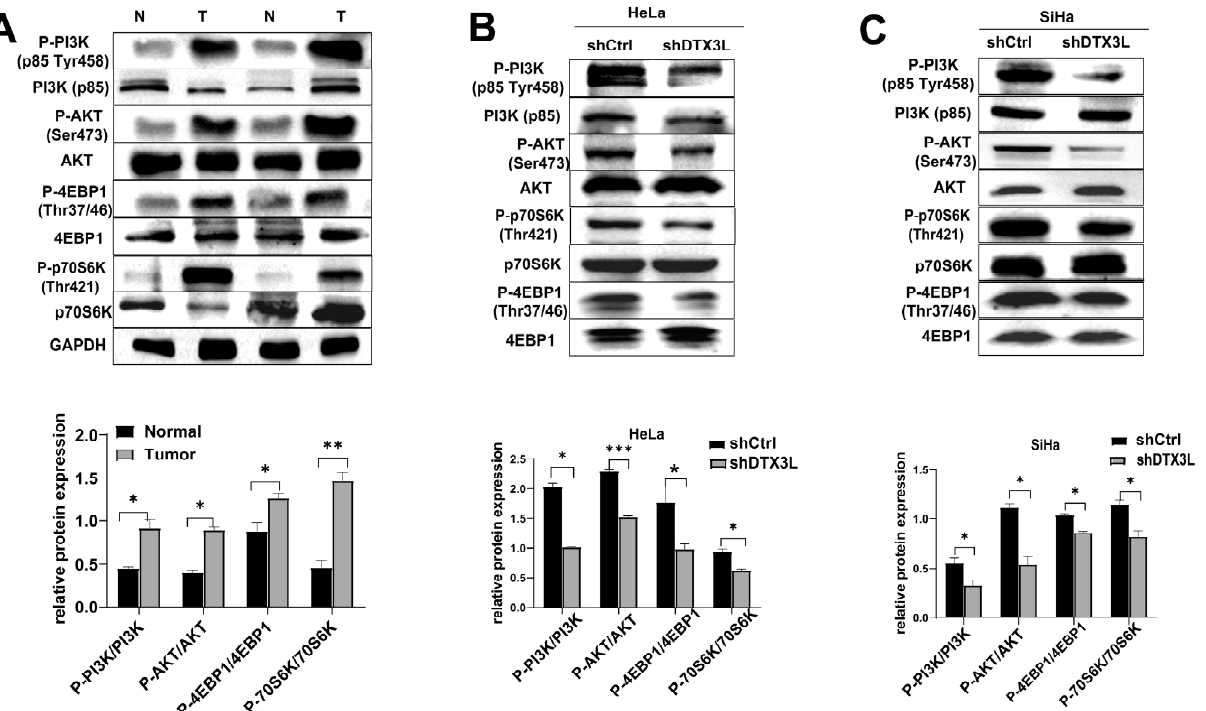
Figure 7. Knockdown of DTX3L inhibited the PI3K/AKT/mTOR signaling pathway. ( A ) The expression levels of PI3K/AKT/mTOR-pathway-related proteins in CC tumor tissues and normal tissues were detected using Western blot analysis. ( B , C ) The effect of DTX3L knockdown on the PI3K/AKT/mTOR signal pathway was determined in HeLa or SiHa cells using Western blot analysis. The quantified result is shown below. * p < 0.05, ** p < 0.01, *** p < 0.001.